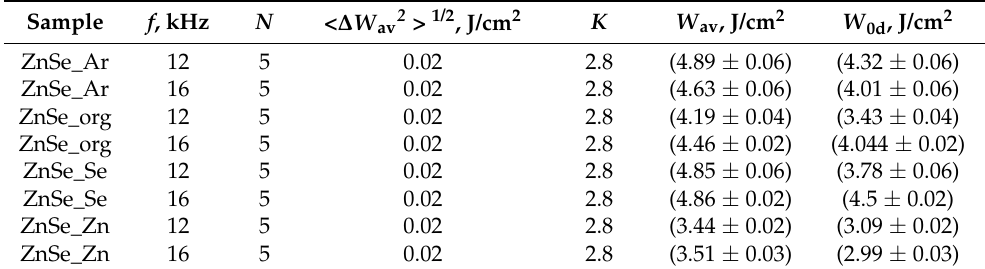
Table 2. The number of the damaged sites, N ; the average quadratic error, < ∆ W 2 av >; the K coefficient of the error dispersion at the confidence probability of F = 0.95; the average LIDT fluence, W av ; the 0-probability LIDT fluence, W 0d , for the ZnSe samples at different PRR ( f ) of the Ho 3+ :YAG laser: 12 or 16 kHz. The exposure duration was 1